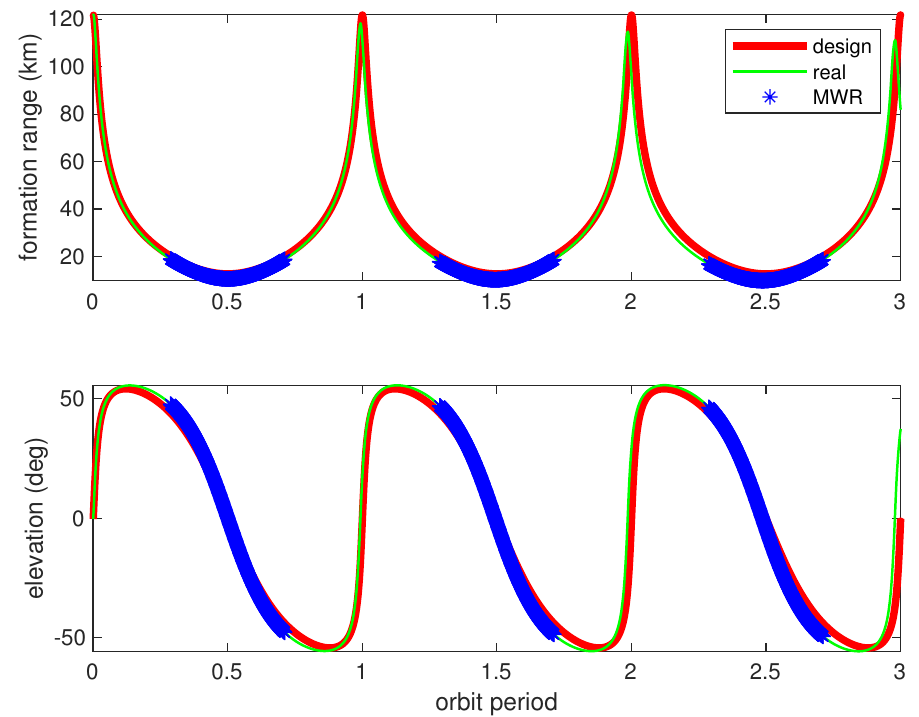
Figure 5. Formation range and elevation angles (design and real values). The red lines denote the designed spacecraft formation flying (SFF) relative range ( top ) and relative elevation angles ( bottom ) during three orbit periods, and the green lines denote the same values of SFF in real orbit perturbations. The blue lines denote the mission operation orbit during apogee for precise SFF guidance, navigation, and control (GNC) technology